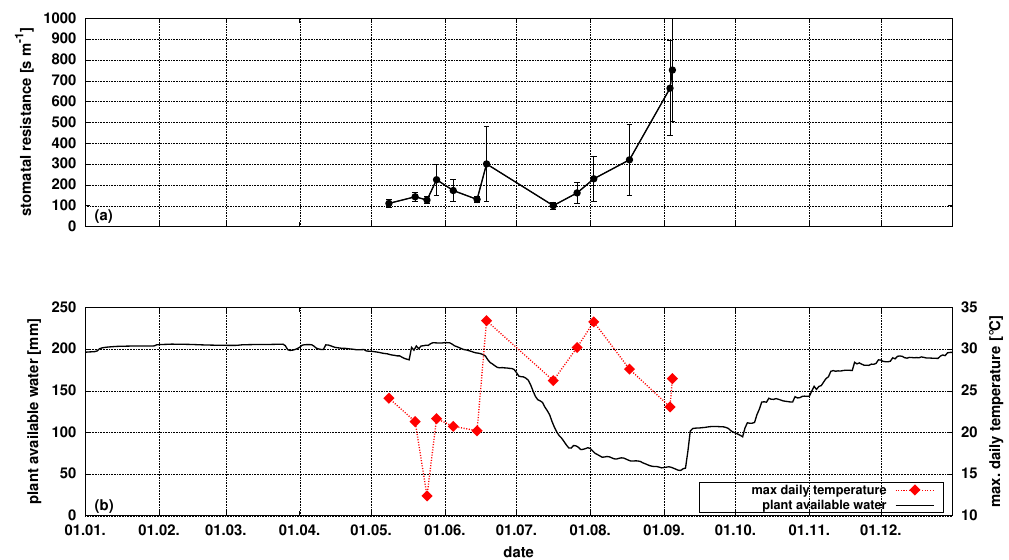
Figure 2. (a) Means and standard deviations of stomatal resistance of sun leaves derived from 10 to 11 repetitions every day at 10 mea- surement plots and (b) the plant available water, calculated from soil water content measurements until 1m soil depth and daily maximum temperature at the poplar SRC Reiffenhausen in 2013. High temperatures affecting stomatal resistance (18 June); starting from August drought stress occurred, increasing the stomatal